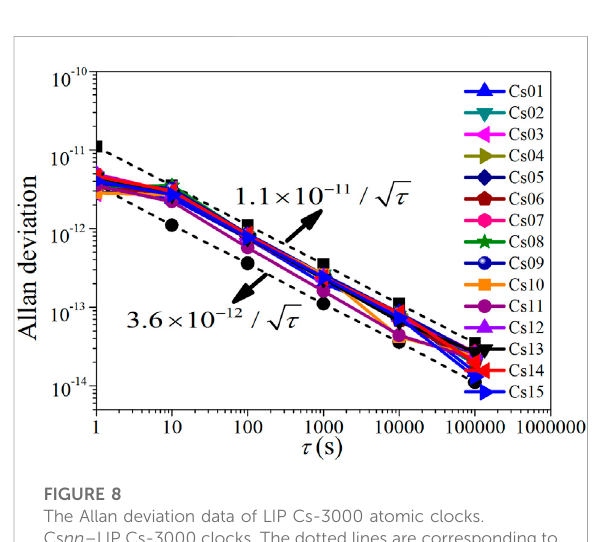
FIGURE 9 The fractional frequency of LIP Cs-3000 cesium atomic